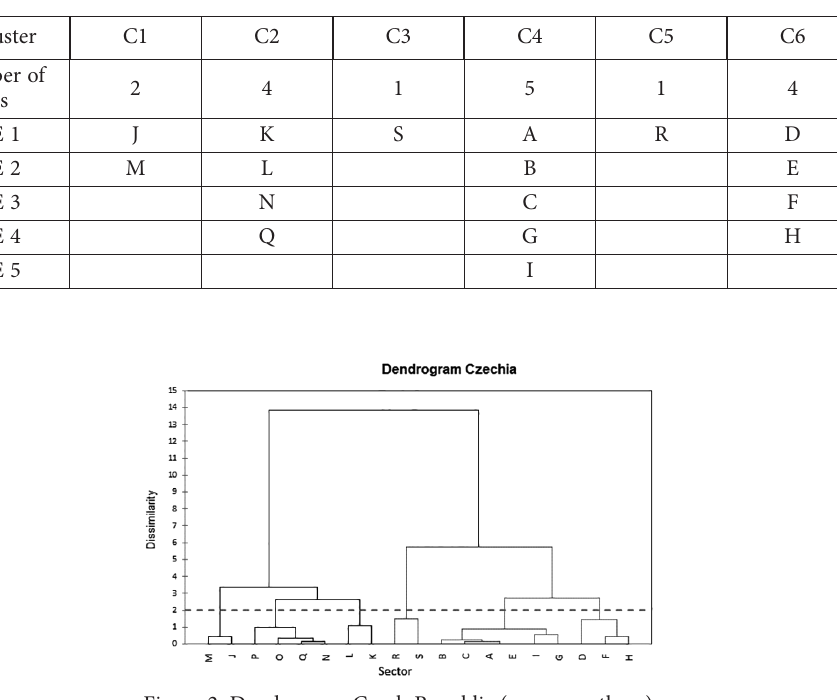
Table 3. Clusters of Slovakia (source: authors)